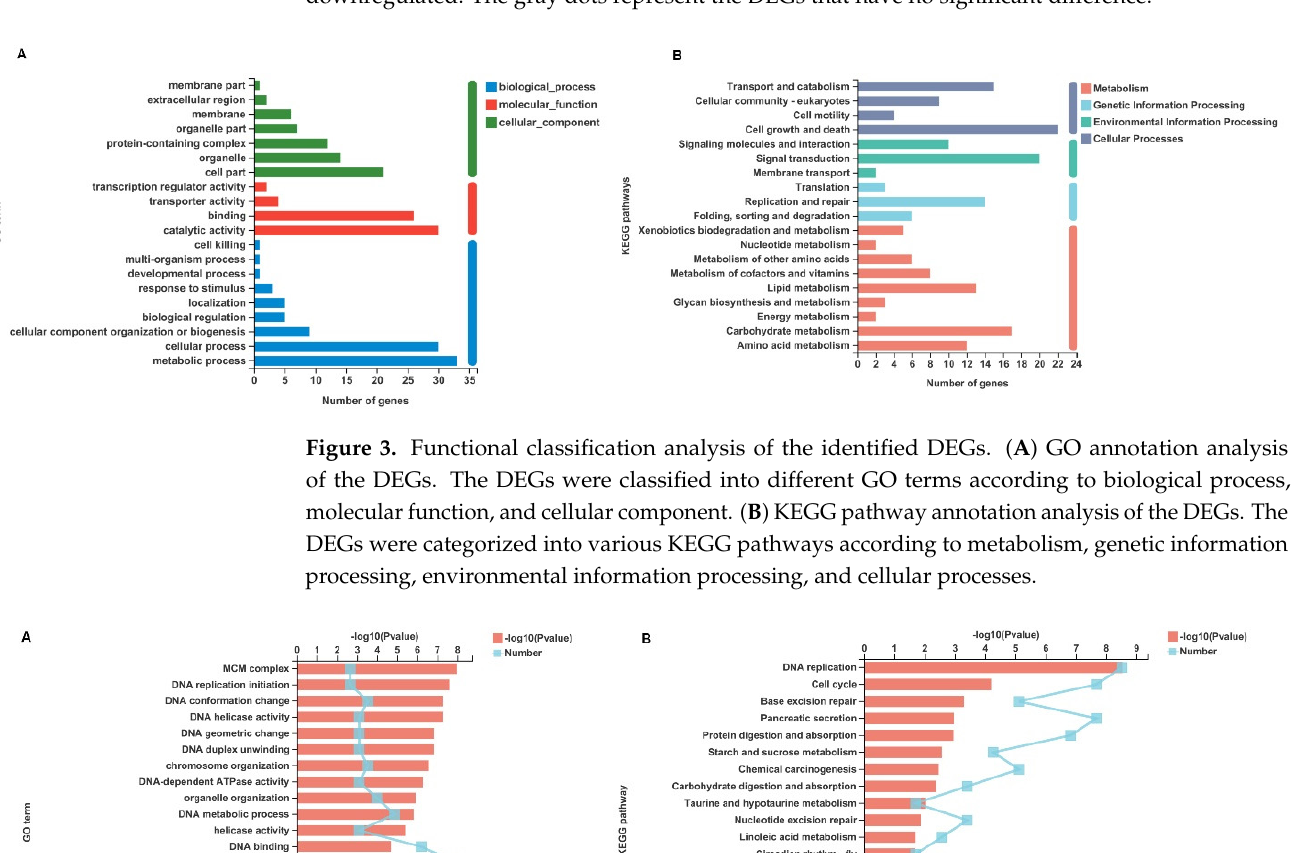
Figure 2. Volcano diagram of the DEGs in WSSV − infected shrimp after IE1 knockdown. The x − axis indicates the fold change of unigenes/transcripts between dsRNA − IE1 and dsRNA − EGFP group, and the y − axis shows the statistical significance of the differences ( p value). Red dots represent the DEGs that are significantly upregulated, whereas green dots represent the DEGs that are significantly downregulated. The gray dots represent the DEGs that have no significant difference.